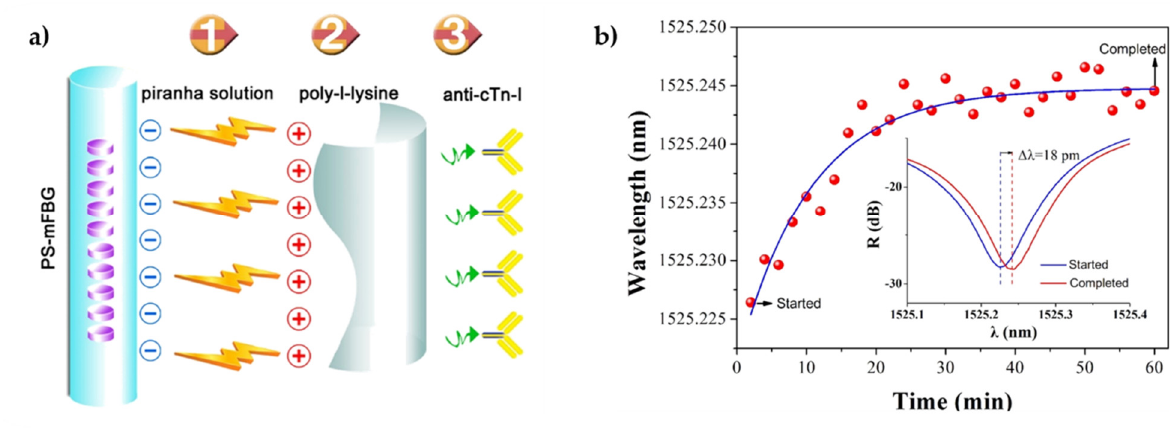
Figure 14. Phase-shifted microfiber Bragg grating (PS-mFBG) functionalized for specific detection of cTn-I as a cardiac biomarker: ( a ) PS-mFBG functionalized via electrostatic interactions, (1) using piranha solution yielding a negative surface and then (2) using poly-l-lisine as a positive polymer intermediary layer where the (3) anti-CTn-I antibodies with the opposite surface charge physically adsorbed via electrostatic interactions; ( b ) wavelength variation of the notch, represented in the inset, as function of time during the specific binding recognition. Reprinted with permission from ref. [109]. Copyright 2018 Elsevier.